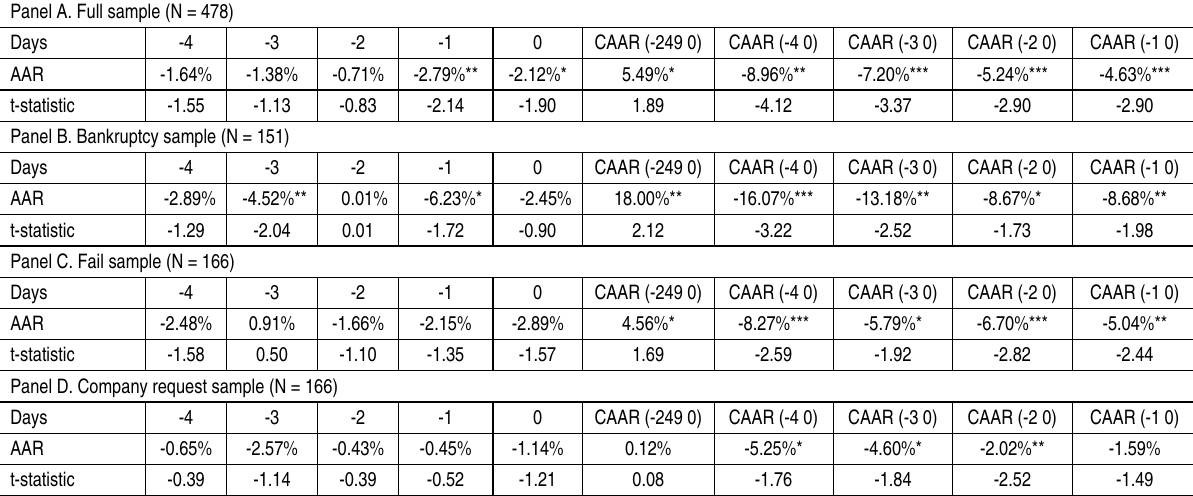
Table 2. Average abnormal returns and cumulative average abnormal returns around delistings announcement days